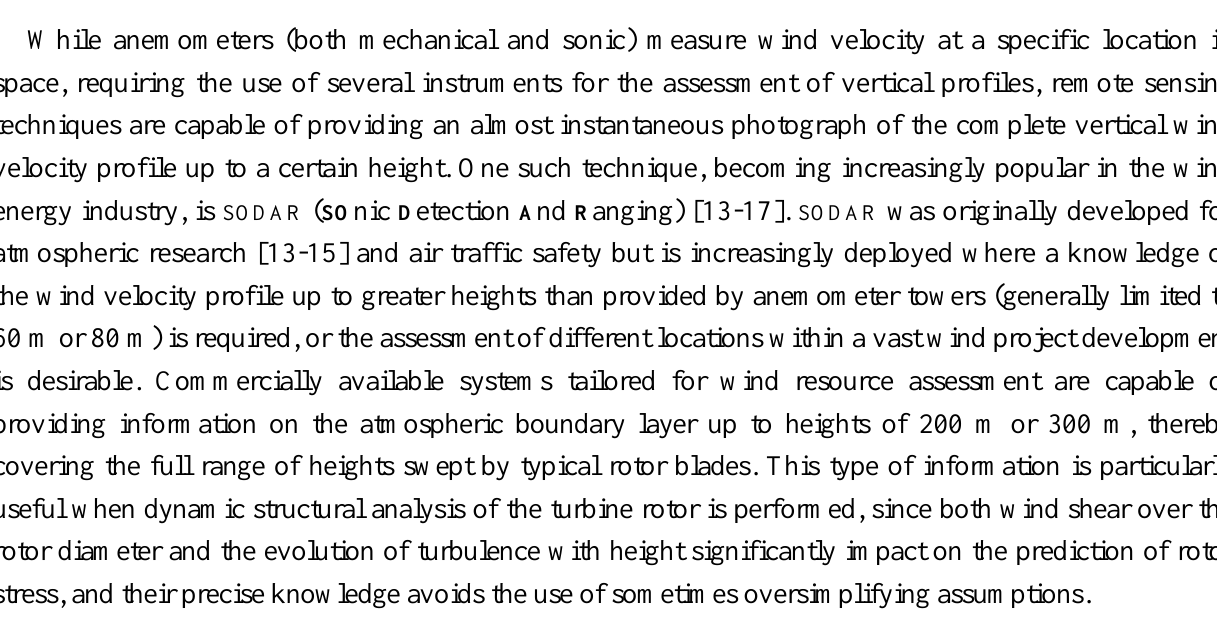
Figure 5. Transfer function of a sonic anemometer as a function of the dimensionless spatial frequency k l for different normalized delay times. M 1 = 0) shown for reference case ( M ∞